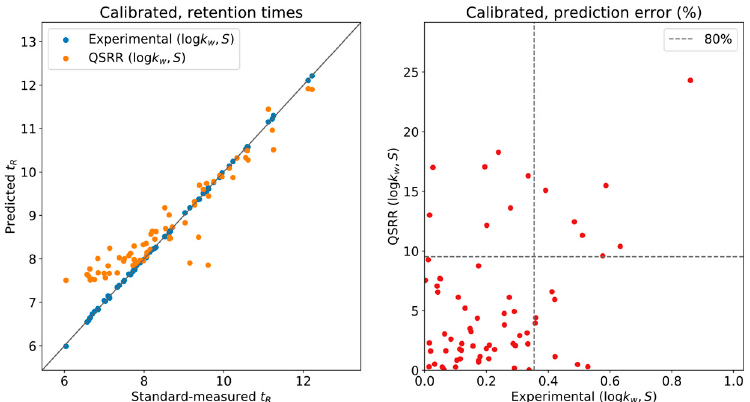
Figure 2. Calibrated retention times.